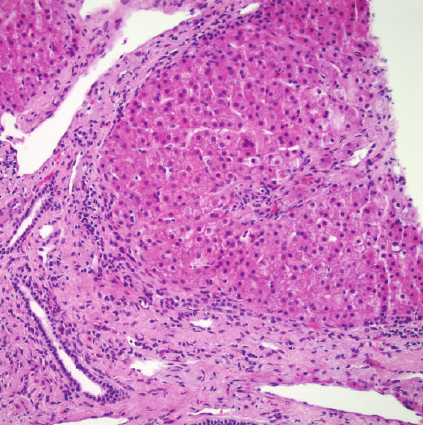
Figure 1: Minimally inflamed portal tracts, with subtle ductular proliferation.